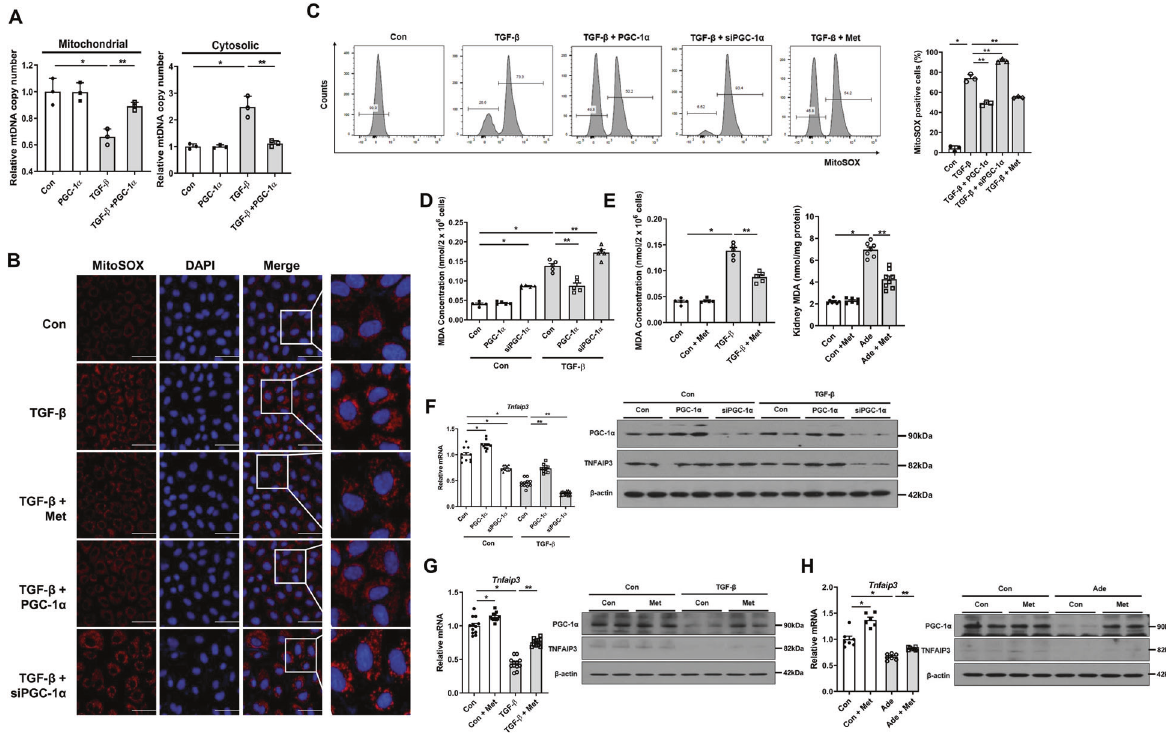
Fig. 8 PGC-1 α regulates the release of mtDNA, oxidative stress, and TNFAIP3 to regulate the NLRP3 in fl ammasome. A mtDNA copy numbers were decreased in the mitochondrial fraction, while increased in cytosolic fraction in TGF- β 1-treated RTECs, which were reversed by Ppargc1a overexpression. B Confocal microscopy analysis with MitoSOX staining revealed increased production of mitochondria-generated ROS in TGF- β 1-treated RTECs, which were reduced with overexpression of Ppargc1a and metformin. Conversely, siPGC-1 α exacerbated mitochondrial ROS production. C Detection of mitochondria-generated ROS in TGF- β 1-treated RTECs by FACS analysis. D Measurement of oxidative stress levels by MDA showed a reduction of oxidative stress levels in TGF- β 1-treated RTECs with overexpression of Ppargc1a and metformin, which were increased by siPGC-1 α . E The oxidative stress levels measured by MDA were reduced in adenine-fed mice with metformin. F , G mRNA and protein expression levels of TNFAIP3 in TGF- β 1-treated RTECs were increased with overexpression of Ppargc1a and metformin, which were reduced by siPGC-1 α . H mRNA and protein expression level of TNFAIP3 in adenine-fed mice was increased with metformin. Note: * P < 0.05 vs. control; ** P < 0.05 vs. TGF- β -treated RTECs or adenine-fed mice. PGC-1 α peroxisomal proliferator- γ coactivator- 1 α ; mtDNA mitochondrial DNA; NLRP3 NOD-like receptor family, pyrin domain-containing 3; RTEC; renal tubular epithelial cell; ROS reactive oxygen species; MDA malondialdehyde; TNFAIP3 tumor necrosis factor α induced protein 3; FACS Fluorescence-activated cell sorting; Ade adenine; Met